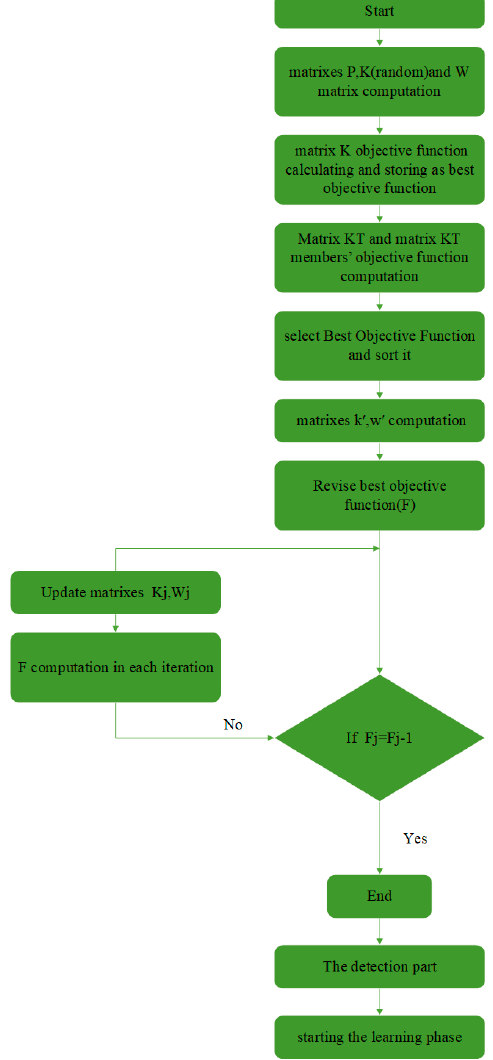
Figure 4. The framework of the IPS algorithm.